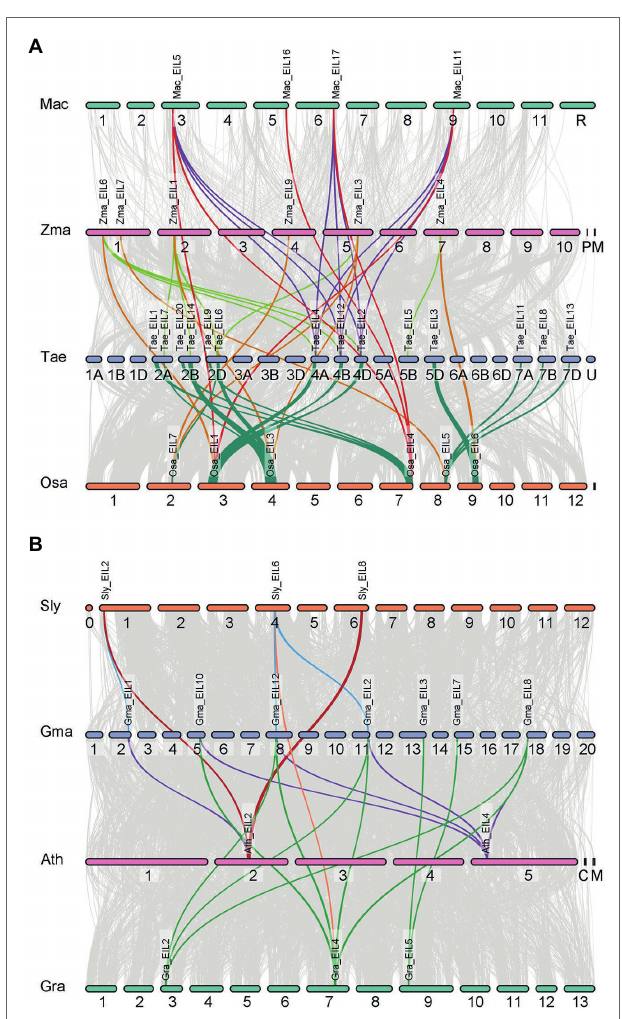
FIGURE 7 | Synteny analysis of EINs/EIL genes between four dicotyledons and four monocotyledons. Gray lines in the background indicate the collinear blocks within two plant genomes, while the colorful lines highlight the syntenic EIL gene pairs. (A) Synteny analysis of EINs/EIL genes between four monocotyledons. And the species names with “Mac,” “Zma,” “Tae,” “Osa” indicate Musa acuminata , Zea mays , Triticum aestivum , and Oryza sativa , respectively. (B) Synteny analysis of EINs/EIL genes between four dicotyledons. And the species names with “Sly,” “Gma,” “Ath,” “Gra” indicate Solanum lycopersicum , Glycine max , Arabidopsis thaliana , and Gossypium raimondii ,